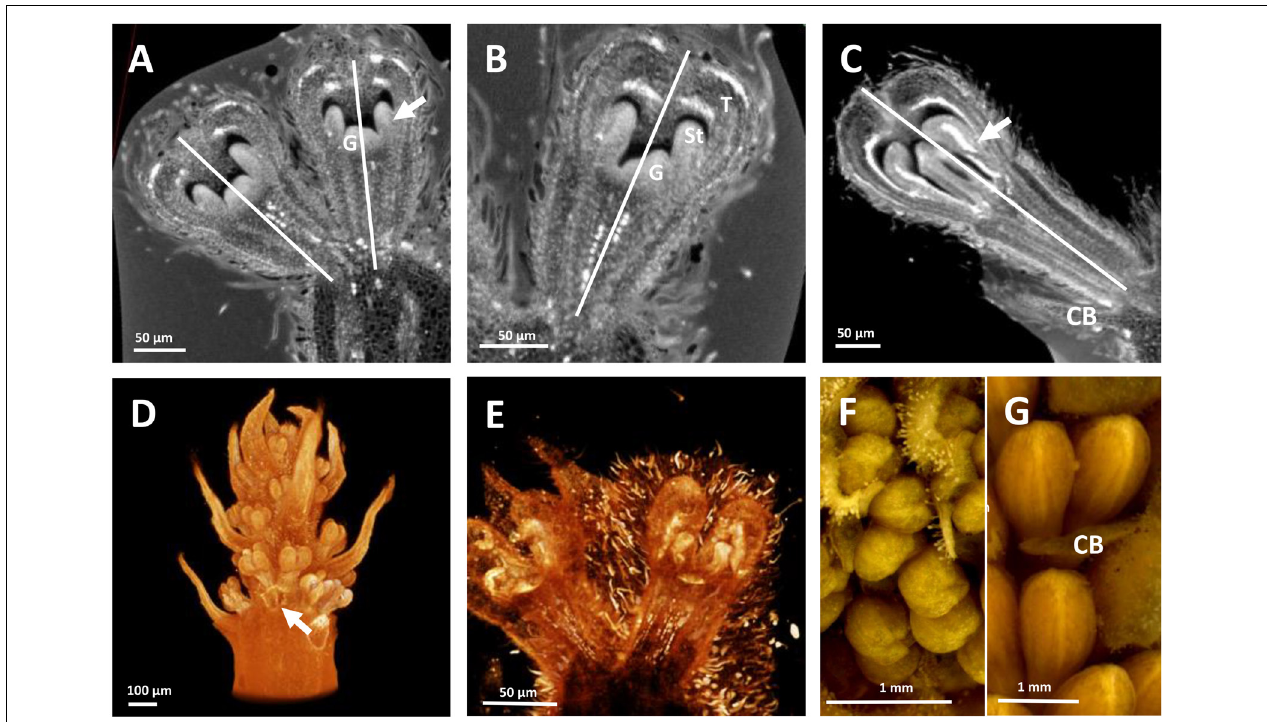
FIGURE 3 | HRXCT images of developing flowers and flower pairs in Stenocarpus davallioides (A–C) , Alloxylon flammeum (D,E) and HRXCT and stereomicroscope images of inflorescence and flower pairs in Grevillea petrophiloides (F,G) . (A) Virtual longitudinal section of a flower pair (lateral view), with slight monosymmetry of the gynoecium (G) with regard to the vertical floral axis, visible on the right; the arrow points to the fusion between a stamen and a tepal. (B) Virtual longitudinal section of a flower (front view), showing the monosymmetry of the gynoecium in the vertical axis, while the tepals (T) and adnate stamens (St) are identical. (C) Virtual longitudinal section of a flower at a later stage (lateral view), showing slight asymmetry of the tepals and adnate stamens (the arrow points to the fused zone between a stamen and a tepal) with respect to the vertical axis (CB, common bract). (D) Lateral view of a whole inflorescence, with the common subtending bract of a flower pair removed (arrow). (E) Lateral view of a flower, zygomorphy is not yet apparent. (F,G) Lateral view of flower pairs at two developmental stages (CB, common bract).